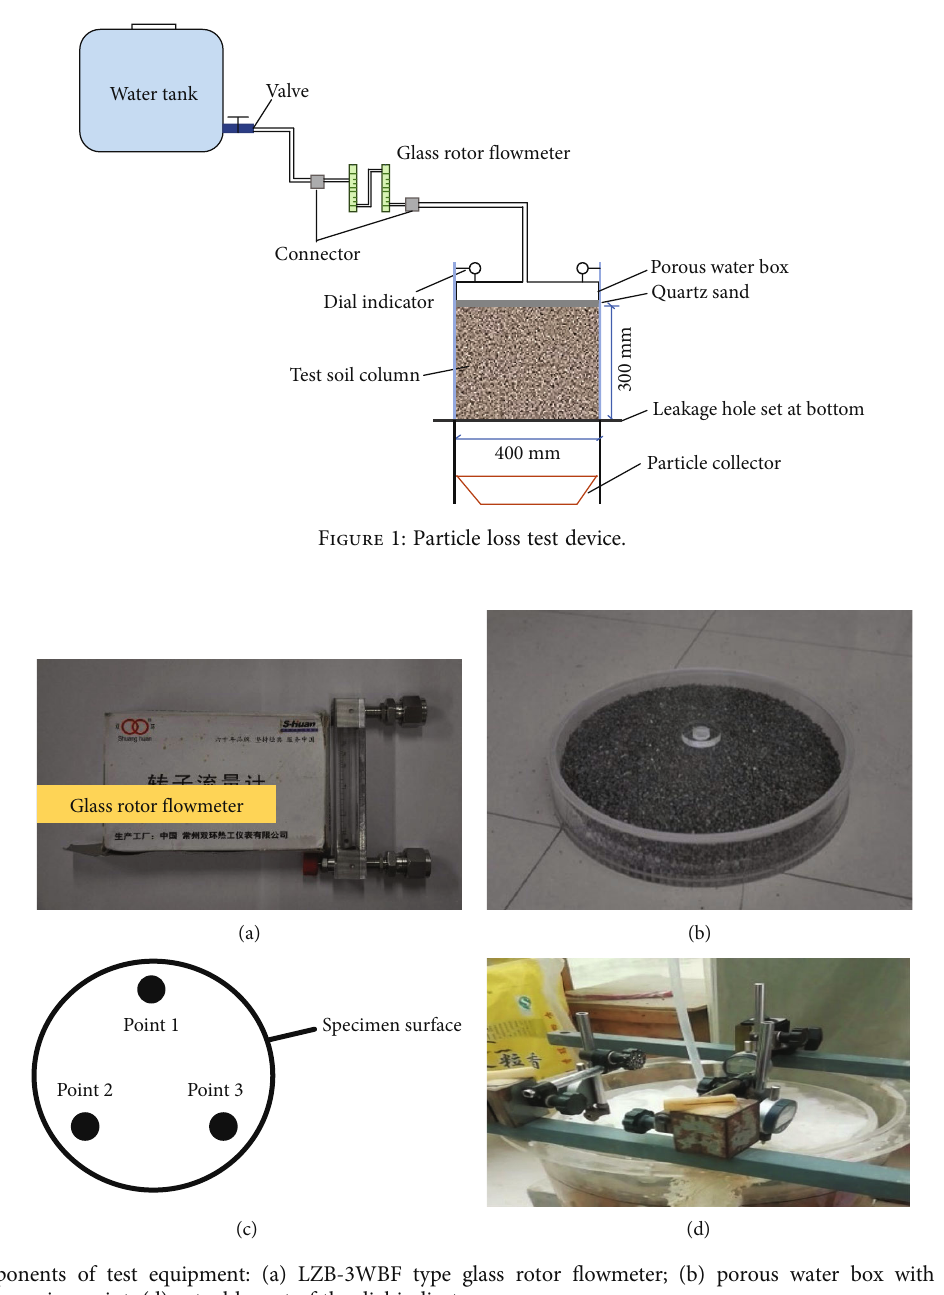
Table 1. The fi ller samples under di ff erent rainfall conditions